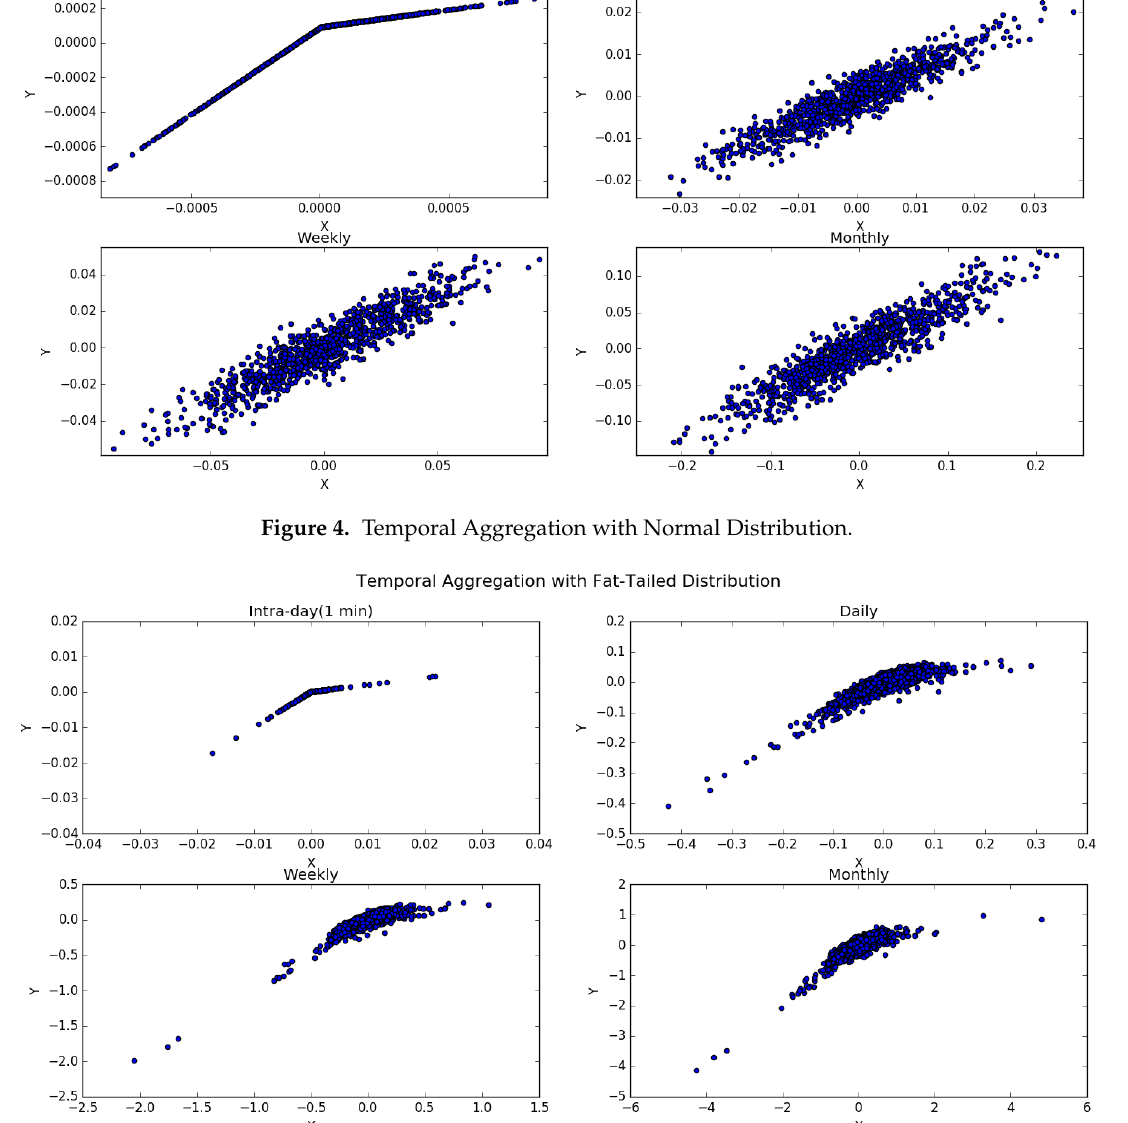
Figure 5. Temporal Aggregation with Fat-tailed